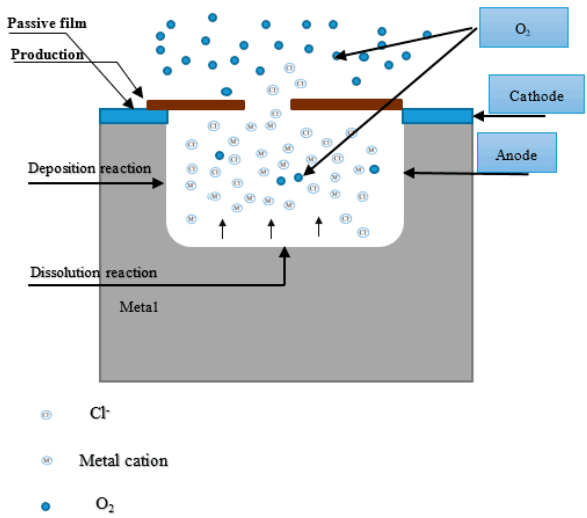
Figure 12. Development of pitting corrosion pits exposed to corrosive media in corrosion-resistant alloy steel bars.